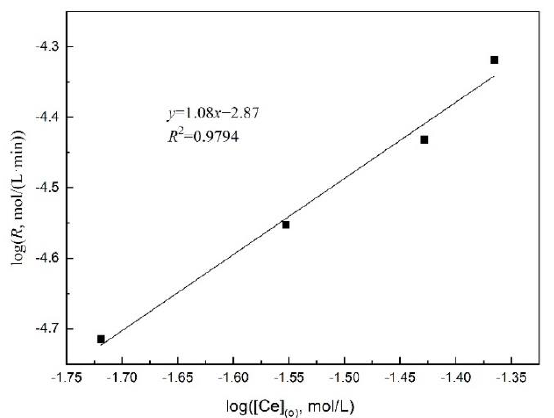
Figure 5. Effect of total cerium concentration in organic phase on the stripping rate (experimental conditions: HEH/EHP concentration 0.1 mol/L, HCl concentration in stripping agent 6.0 mol/L, c (H 2 O 2 ) (a) : c (Ce) (o) 2:1, temperature 25 °C and stirring speed 300 r/min).